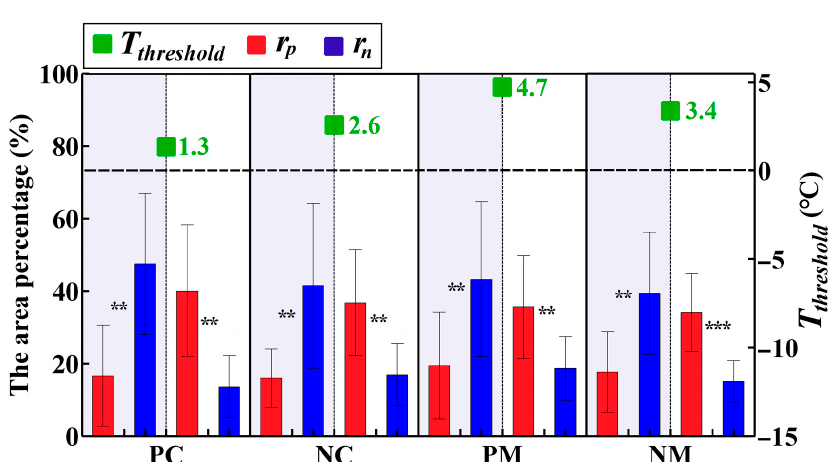
Figure 7. Differences in the average area percentage between positive and negative correlations on both sides of the temperature threshold ( T threshold ) during the growing season. *** and ** indicate difference significant at p < 0.001 and significant at p < 0.01, respectively. The PC, PM, NC, and NM represent planted coniferous, planted mixed, natural coniferous, and natural mixed forests, respectively. The whiskers of the bar represent the standard deviation of related data.